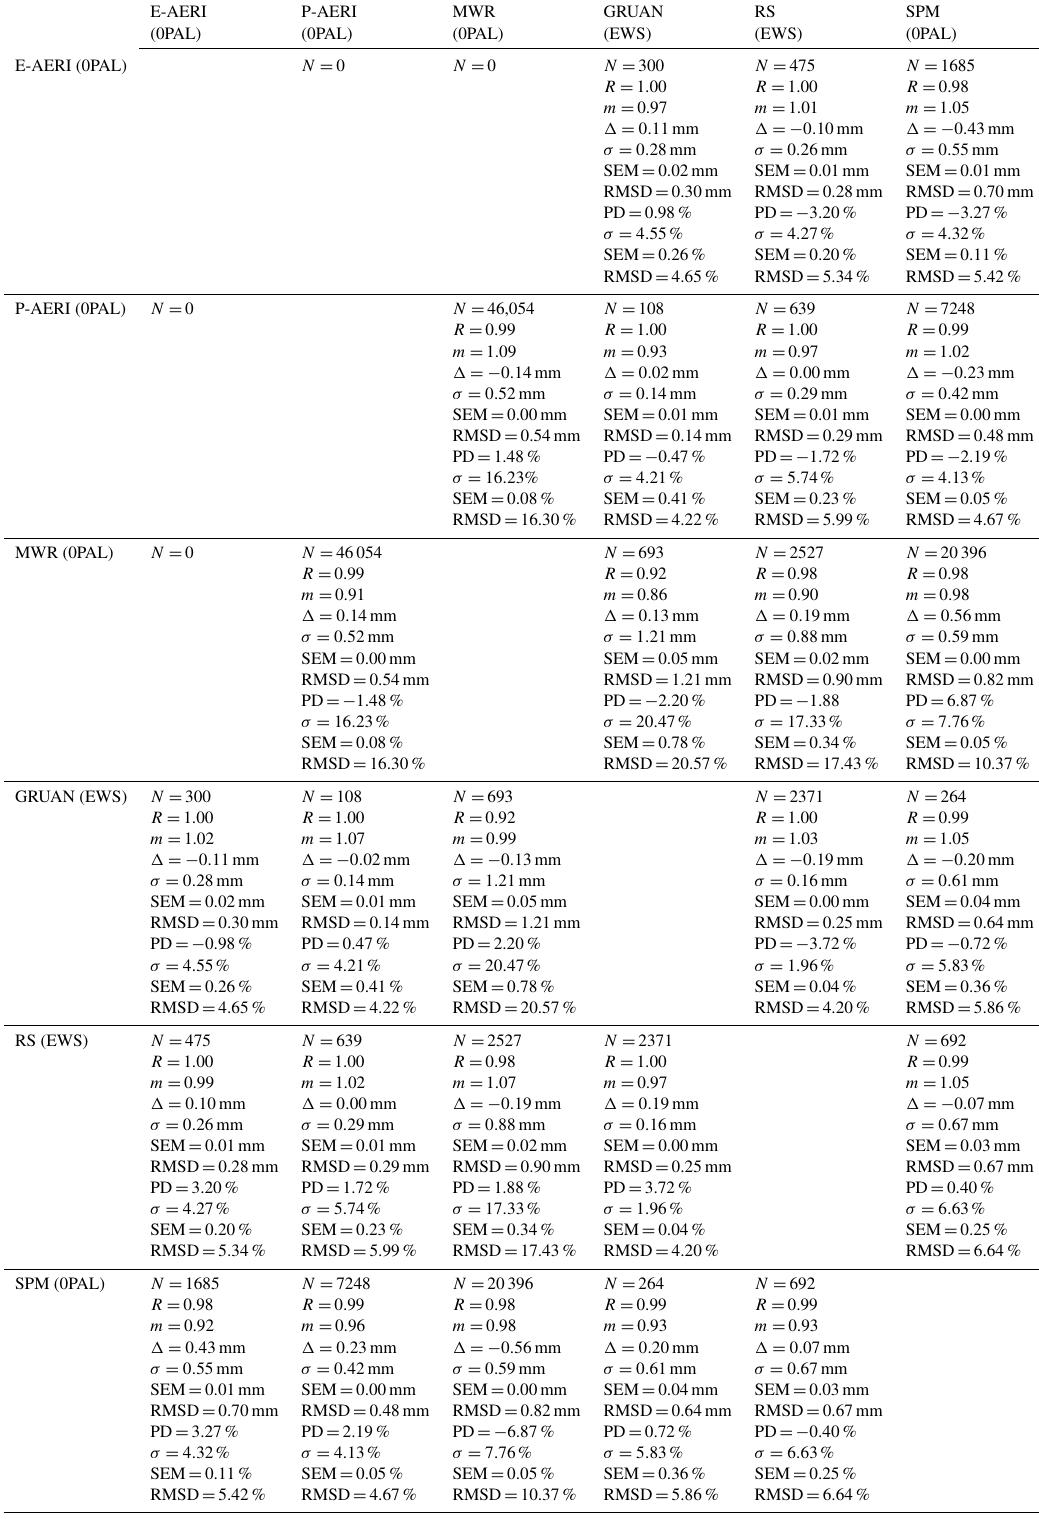
Table 5. Results of intercomparison of PWV measurements at 0PAL, including number of coincidences ( N ), correlation coefficient ( R ), slope of the correlation best fit line ( m ), mean difference ( (cid:49)) , standard deviation of difference ( σ) , standard error of the mean (SEM), and root-mean-square difference (RMSD) in mm and %. Instruments along the x axis (top) are X while instruments along the y axis (side) are Y in Eqs. (1) and (2). A high-resolution version of this table can be found in Table